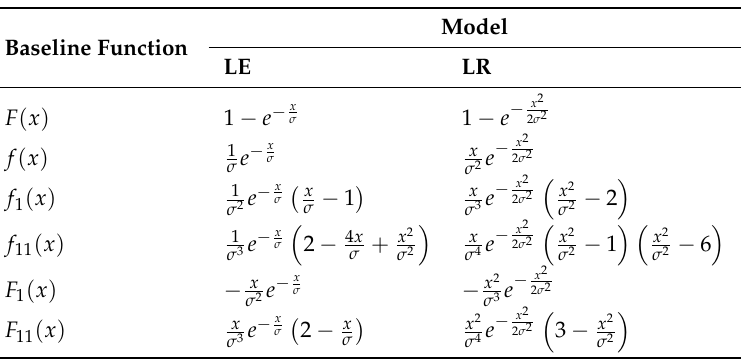
Table 3. Baseline f ( x ) , F ( x ) , f 1 ( x ) , f 11 ( x ) , F 1 ( x ) and F 11 ( x ) functions ( x > 0 and σ > 0) for the Lambert-exponential (LE) and Lambert–Rayleigh (LR)